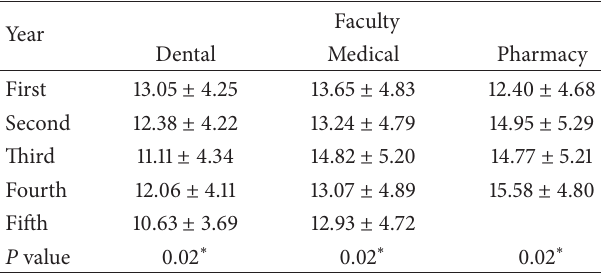
Table 4: Year-wise comparison of mean anxiety scores as per field of